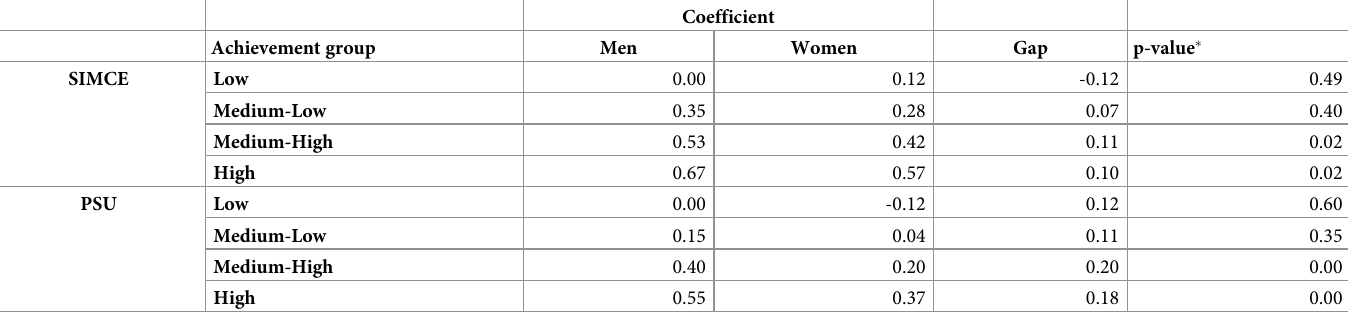
Table 5. Gender gaps comparison for different levels of previous achievement. Estimations based on Model (3) for